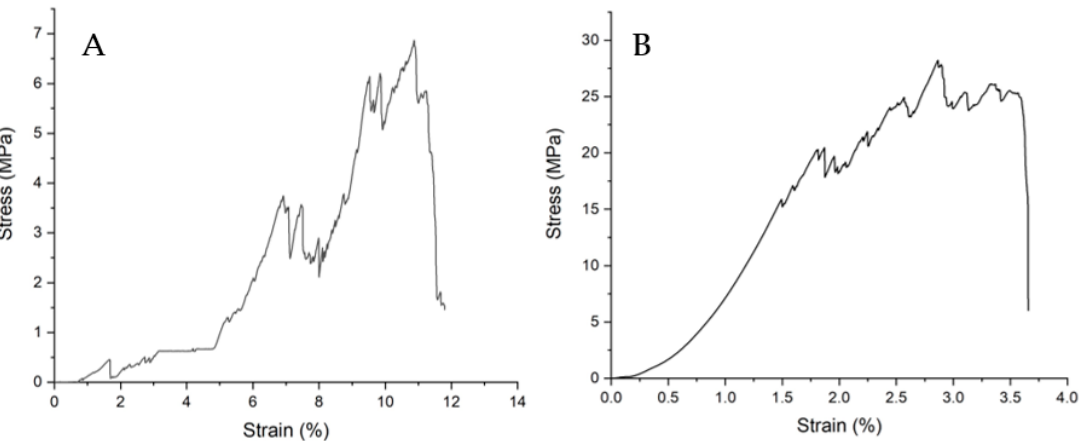
Figure 8. Registered stress-strain curves of the lattice ( A ) and dense samples ( B ), obtained during uniaxial compression tests.